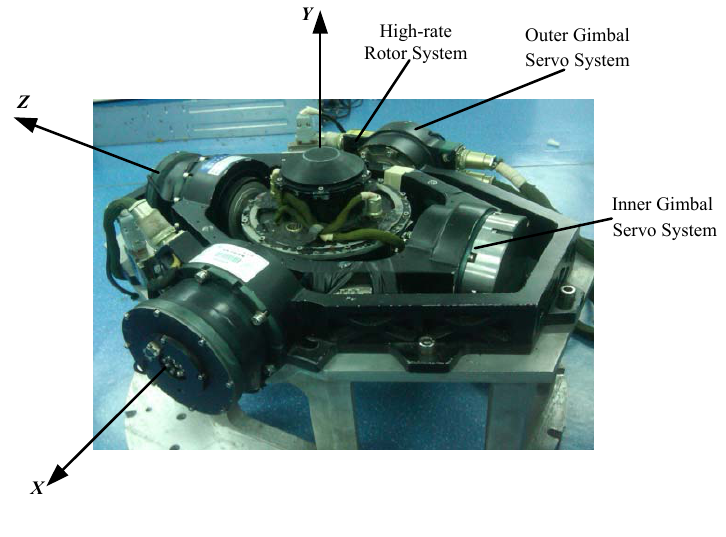
Figure 1. Schematic Diagram of the MSDGCMG Coordinate